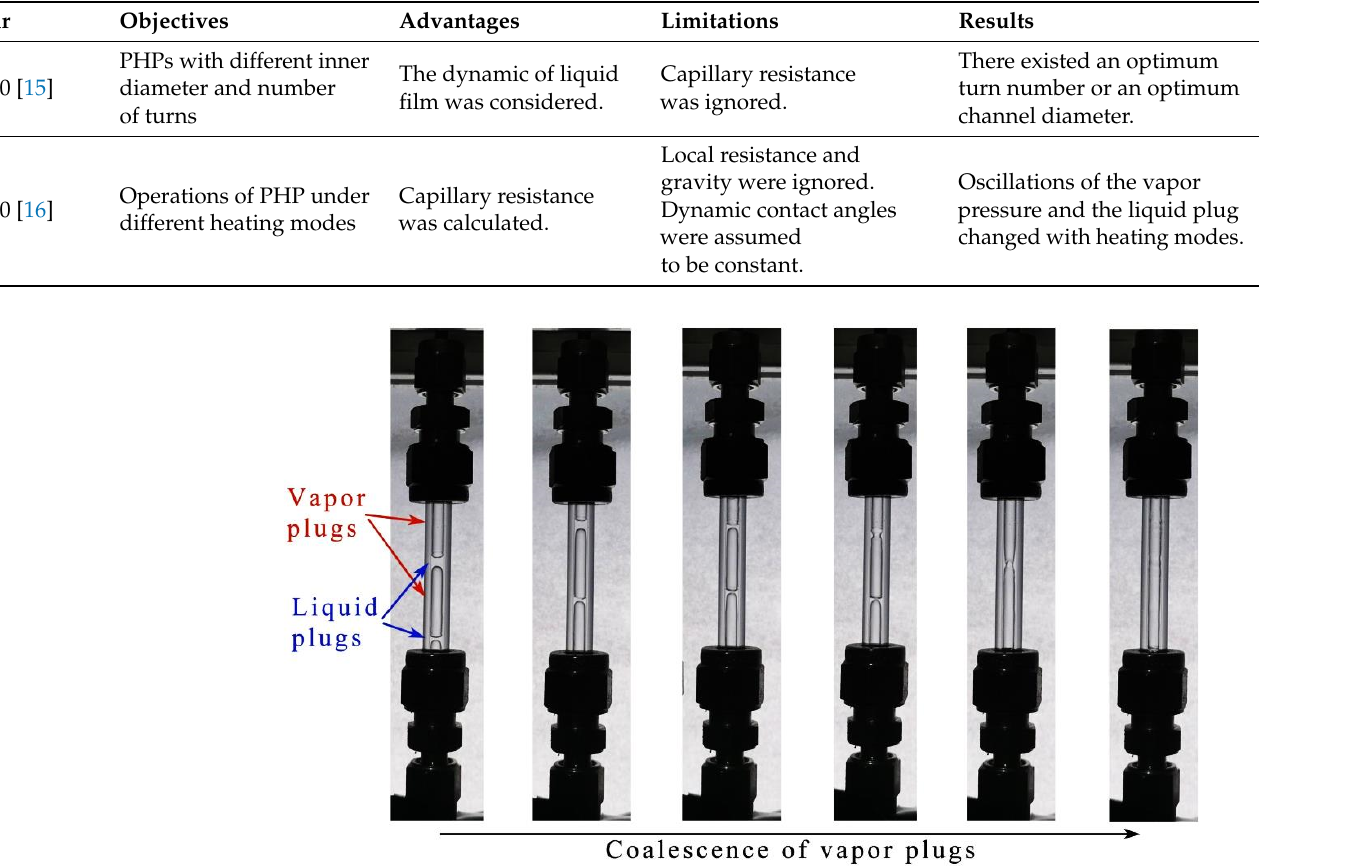
Figure 1. Connection and coalescence of vapor plugs at high input power.